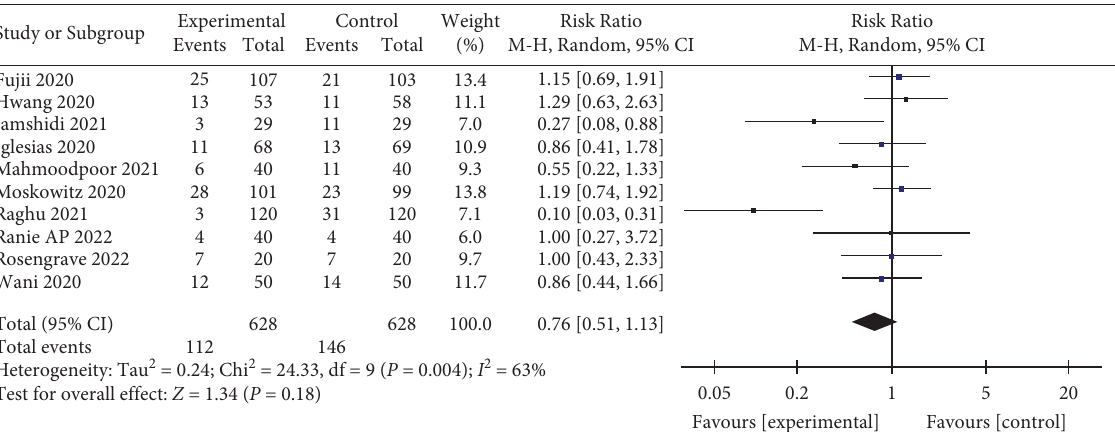
Figure 10: Forest plots for the efect of vitamin C on hospital